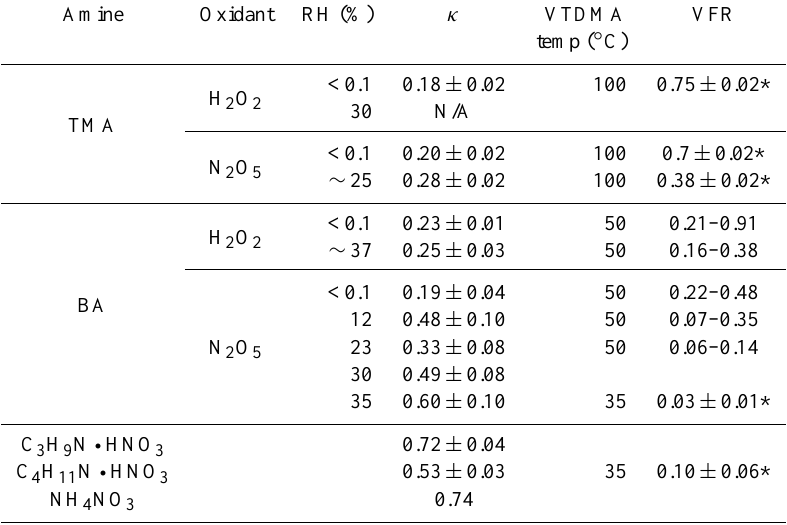
Table 1. κ and VFR values of aerosol formed from reactions with OH (H 2 O 2 as source), NO 3 (N 2 O 5 as source), and HNO 3 . The range of VFR is shown (e.g., 0.21–0.91) when standard deviation exceeds 0.06. Amine Oxidant RH (%)